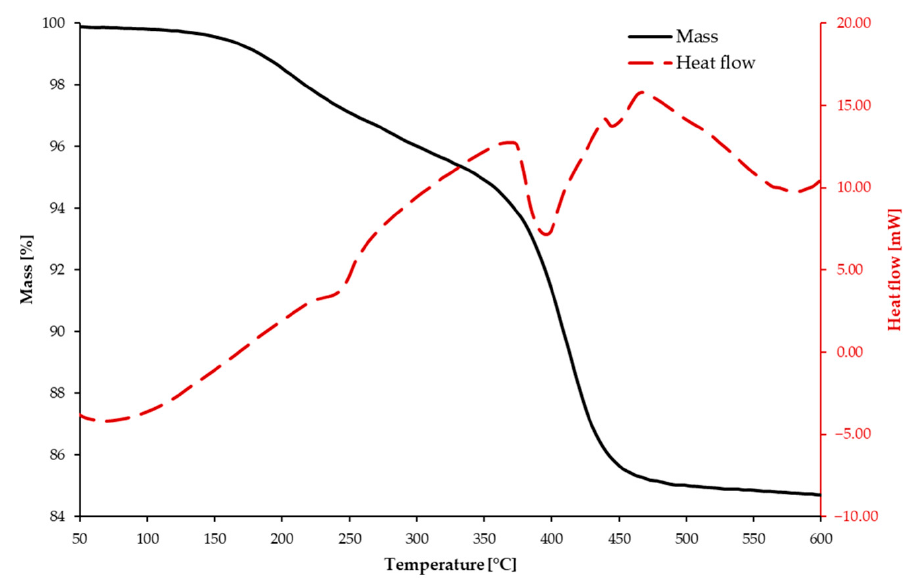
Figure 15. TG–DSC curves of the DLPed Al 2 O 3 sample.